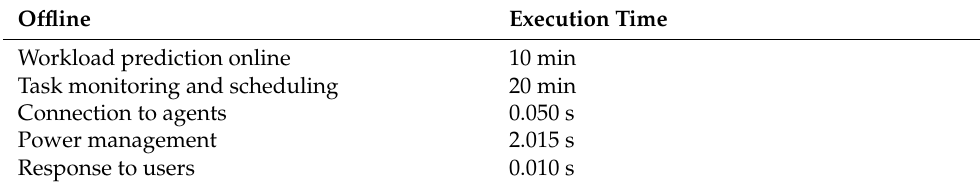
Table 4. Evaluation and analysis of response time.